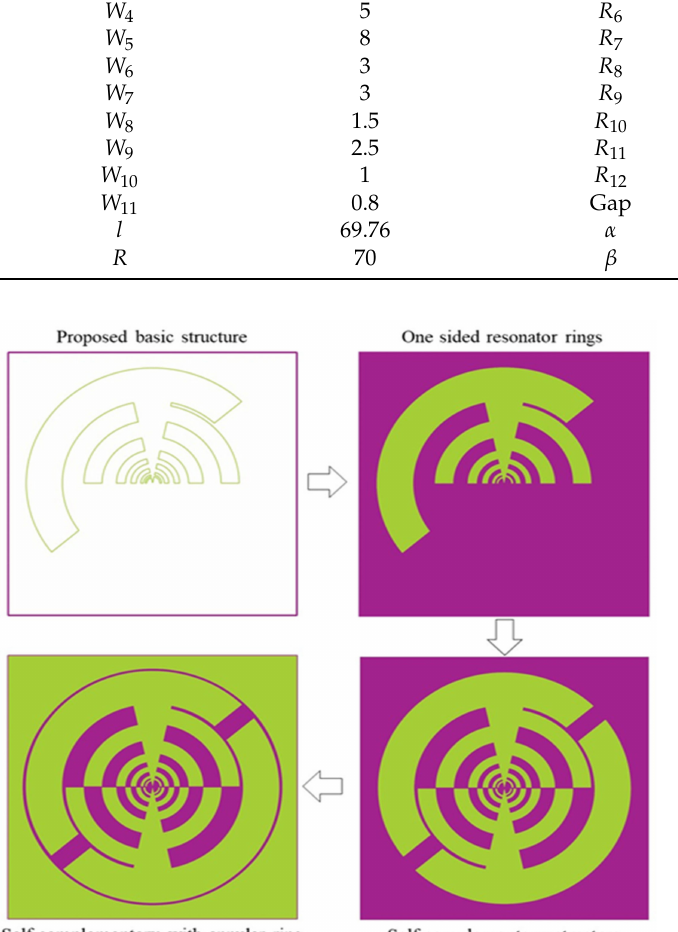
Figure 5. The proposed antenna’s sequential design process, a two-armed log-periodic self- complementary dual-arm teeth structure with a separate port and annular ring